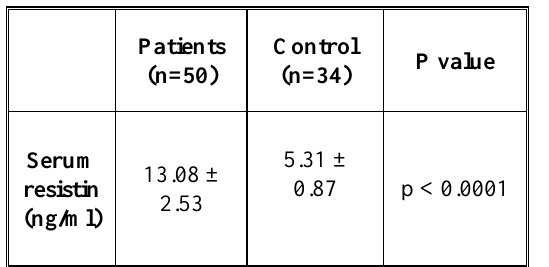
Table 2: Admission serum resistin level in STEMI patients compared to control.